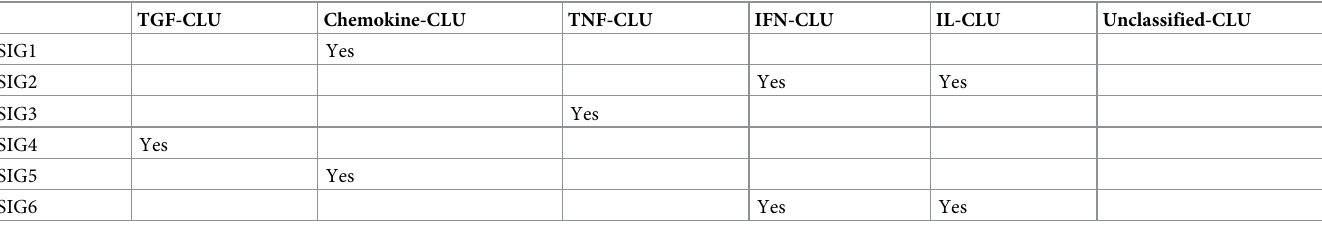
Table 1. The associations between the six gene sets (SIG1-SIG6) and specific clusters (CLU).